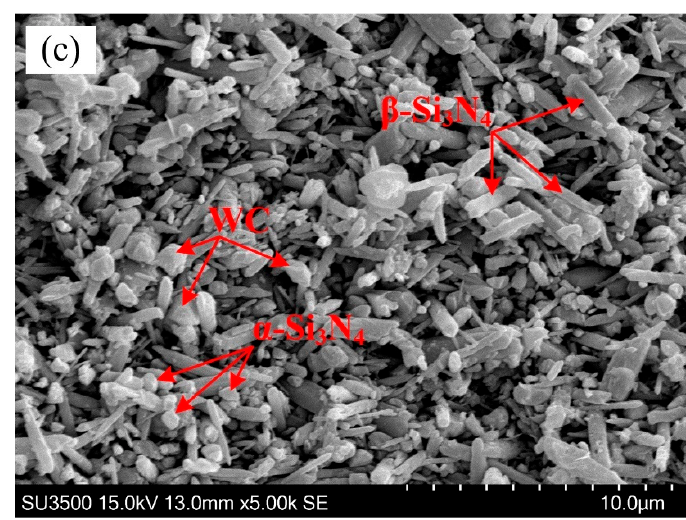
Figure 4. SEM micrograph of the Si 3 N 4 -based ceramic with 1 wt % Co after being corroded. ( a ) 5 wt % WC, ( b ) 10 wt % WC, and ( c ) 15 wt % WC.